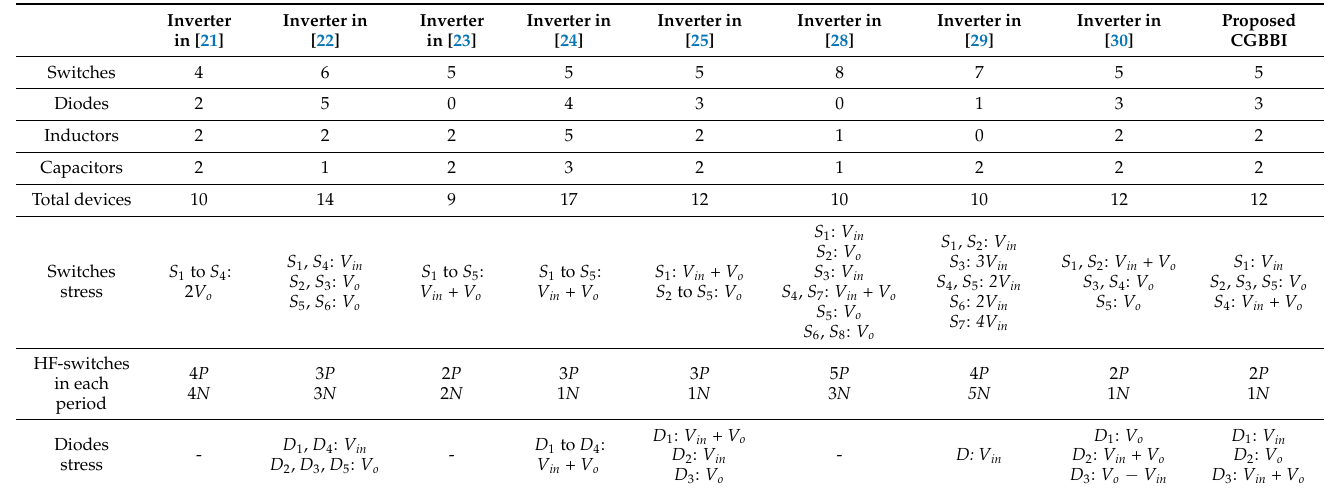
Table 1. Comparison between the proposed CGBBI topology and other common-ground transformer- less